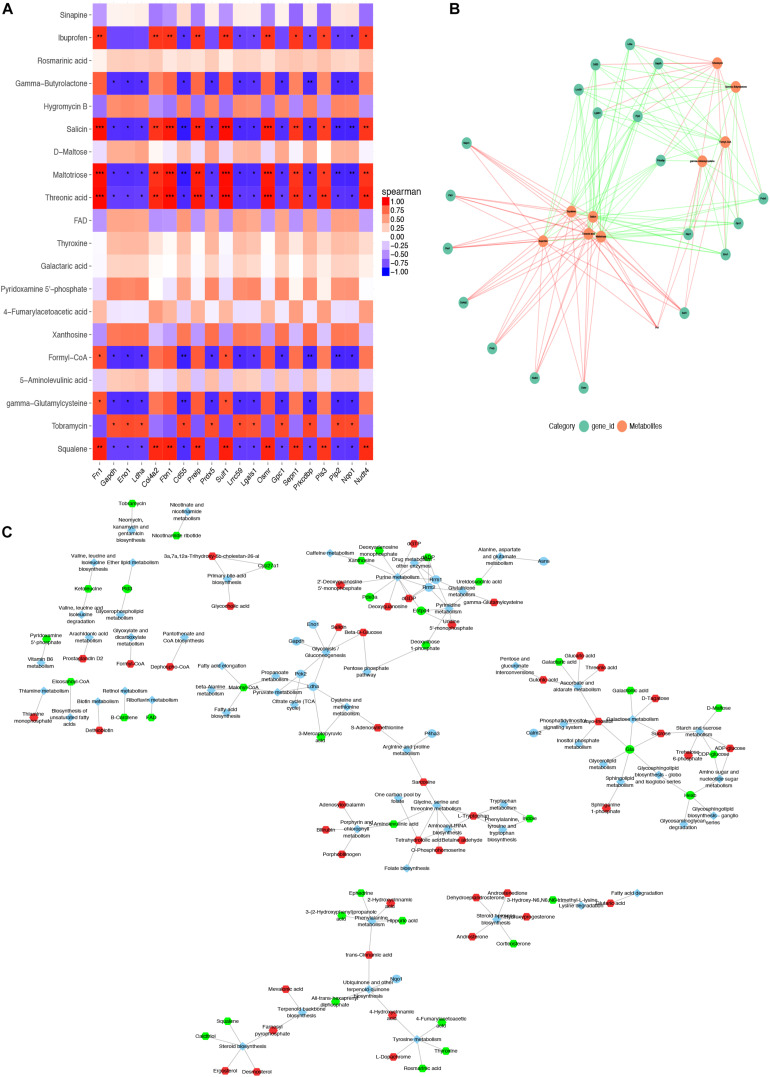
Combined analysis of DEGs and differential metabolites expression in SASCs and PASCs. (A) The heat map of the top 20 DEGs and differential metabolites in SASCs and PASCs. (B) The PPI network of the DEGs and differential metabolites. (C) KGML network analysis of DEGs and differential metabolites. ***P < 0.001, correlation; **P < 0.01, correlation; *P < 0.05, correlation.